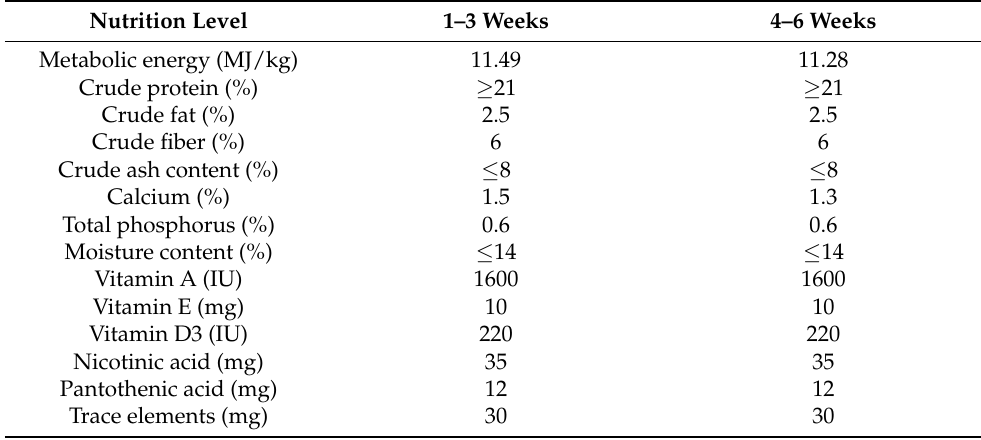
Table 2. Basic diet nutrition